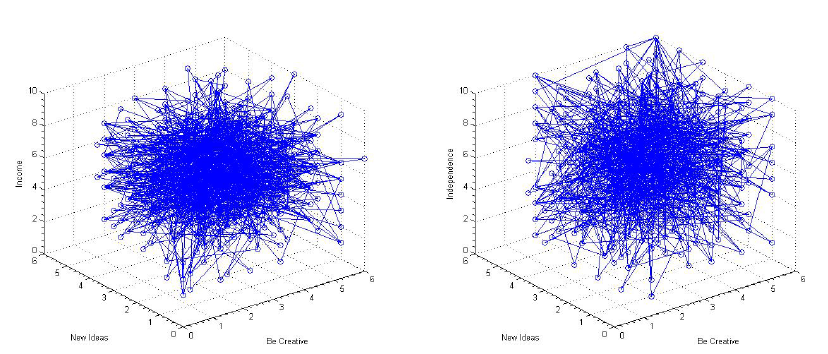
Figure 2. Three dimensions of relationships among new ideas, be creative with income and independence (autonomy) (source: created by